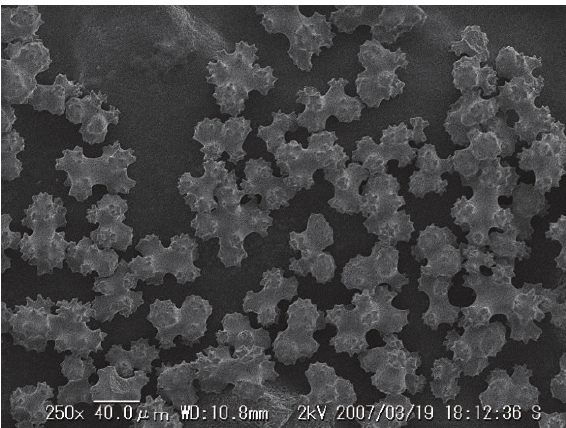
Figure 18: SEM image of sclerites of Corallium elatius ; OCA-